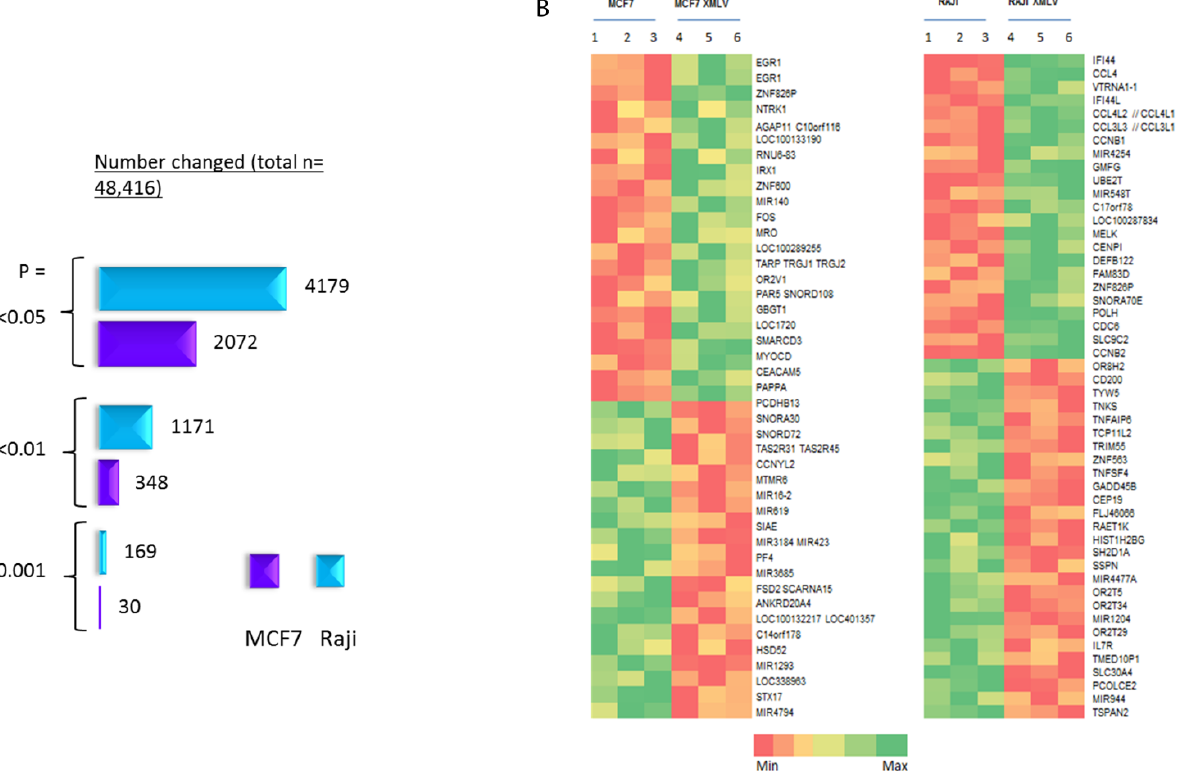
Figure 4. Gene expression microarray analysis (Affymetrix HuGene 2.0ST) of XMLV infected MCF7 and Raji cells. ( A ) Number of changed probe sets at different P value cut-offs; ( B ) Heat map of the most highly up- and down-regulated genes in XMLV-infected MCF and Raji cells, based on a p = <0.05 and fold change >1.5